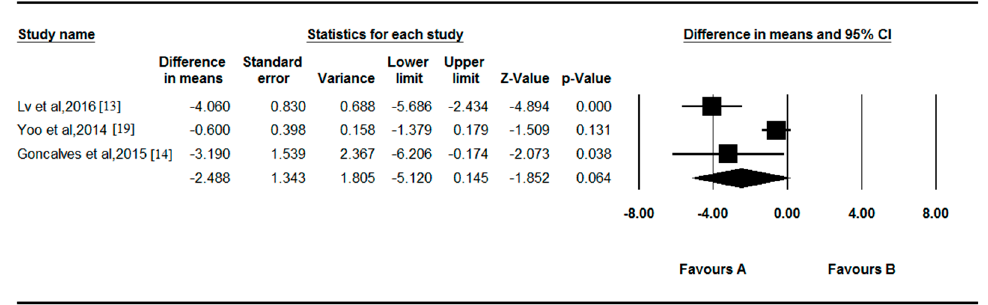
Figure 4. Forest plot of random effects meta-analysis showing the association between serum vitamin D and POAG.